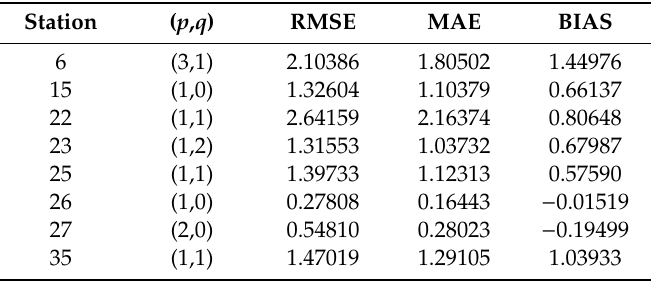
Table 8. RMSE, MAE and bias values in each station for VARMA ( p , q ) models (RMSE: root mean squared error, MAE: mean absolute error, BIAS: bias or historial average error, VARMA: vector autoregressive moving